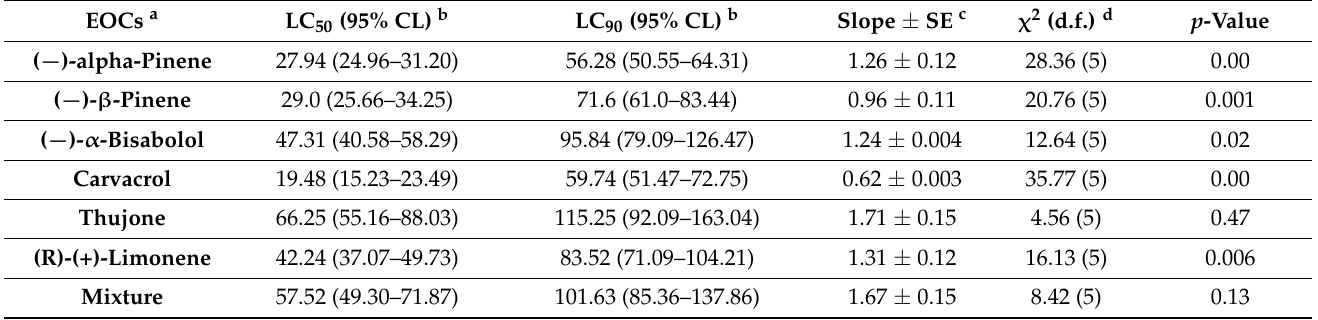
Table 2. Toxicity of different EOCs in fumigant toxicity bioassay against B. dorsalis